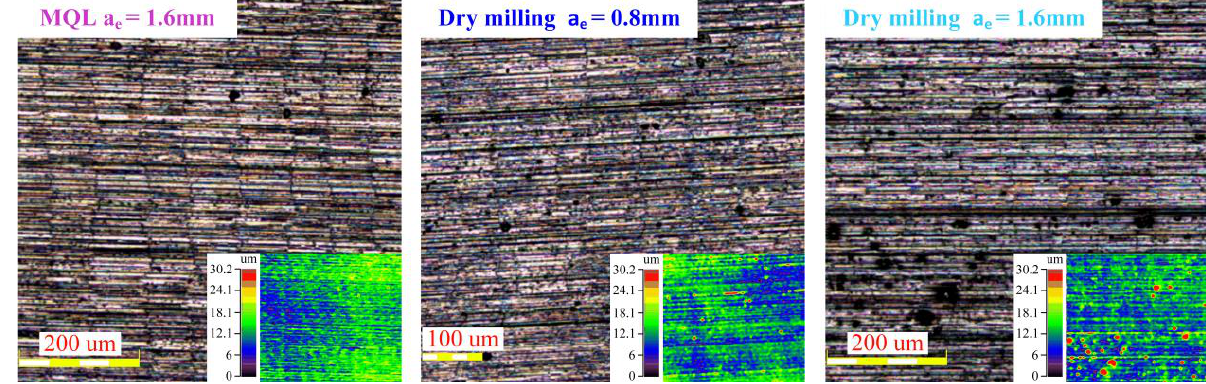
Figure 10. The surface topography of the machined workpiece at different radial cutting depths.